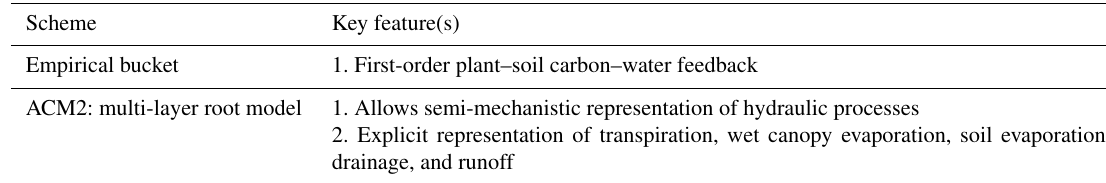
Table A5. Summary of key features for each water cycle sub-model. Scheme Key